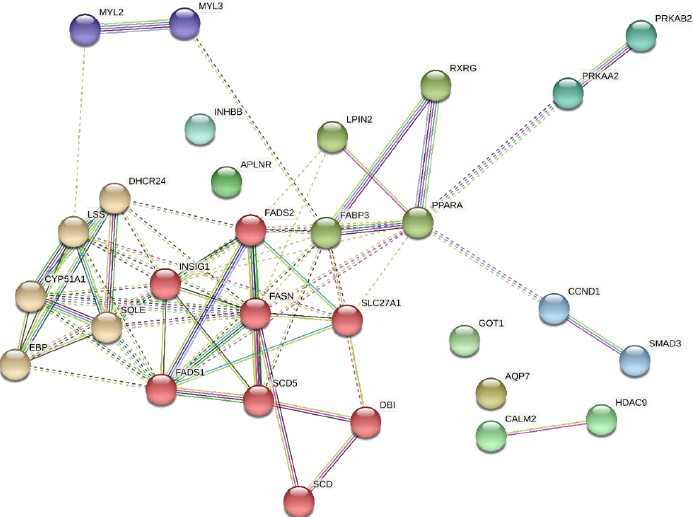
Figure 7. Protein–protein interaction network of DEGs upregulated in G2 that participate in the biological processes and KEGG pathways identified as enriched and highlighted in the G1 × G2 comparison at weaning. Type of interaction (edge color) between nodes (DEGs): light green—text mining; dark green—neighborhood; light blue—curated databases; dark blue—co-occurrence; pink—experiments; purple—protein homology; black—co-expression. A larger number of edges indicate stronger evidence/greater strength of the interaction between two nodes. The nodes that make up the clusters formed (joined by dotted edges) are illustrated with different colors. Figure 8 shows the network of PPI of 23 DEGs downregulated in G2 that participate in the biological processes (GO_BP) and metabolic pathways (KEGG) identified as en- riched and highlighted in the G1 × G2 comparison at weaning due to their relationships with each other and potential relationships with intramuscular adipogenesis and lipogen- esis. Twenty-three edges (significant interactions) and four clusters consisting of eight to two genes were identified. The red, yellow, and dark green clusters were the largest, with eight, three, and three genes, respectively. One of the clusters (dark blue) contained only two genes. The mean clustering coefficient was 0.467. Seven DEGs were disconnected from the network.